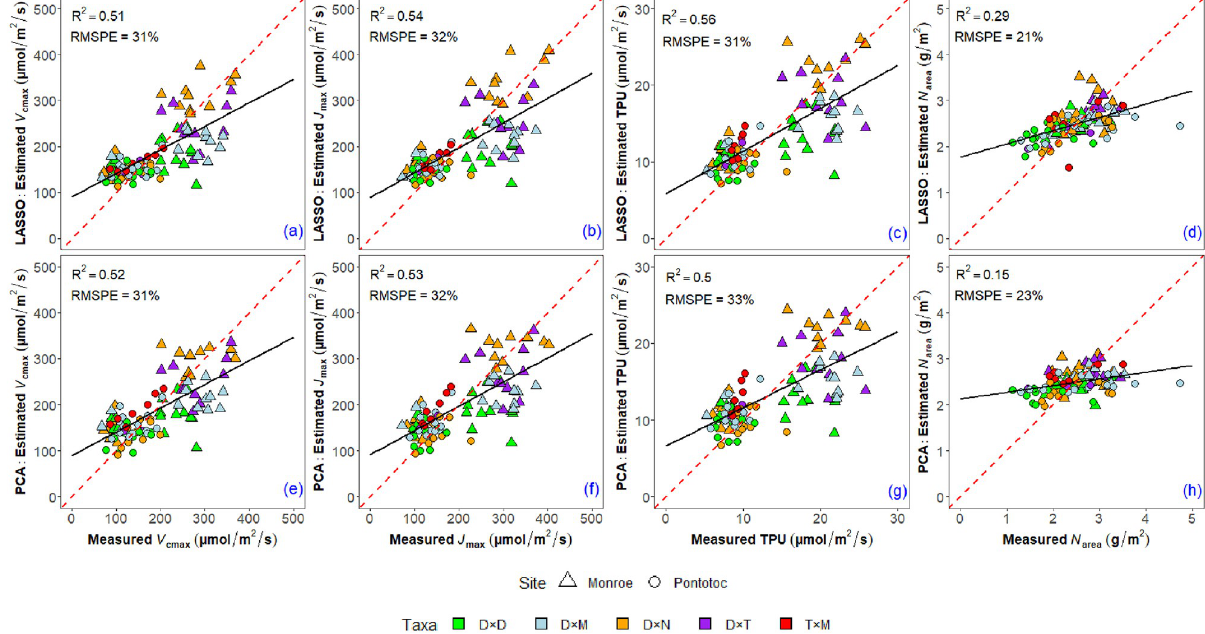
Fig 3. Scatterplots showing the linear relationship between measured and estimated V cmax , J max , TPU and N area for the LASSO models: (a), (b), (c), and (d) and the PCA models: (e), (f), (g), and (h). The solid black line is the regression line, and the dotted red line is the 1:1